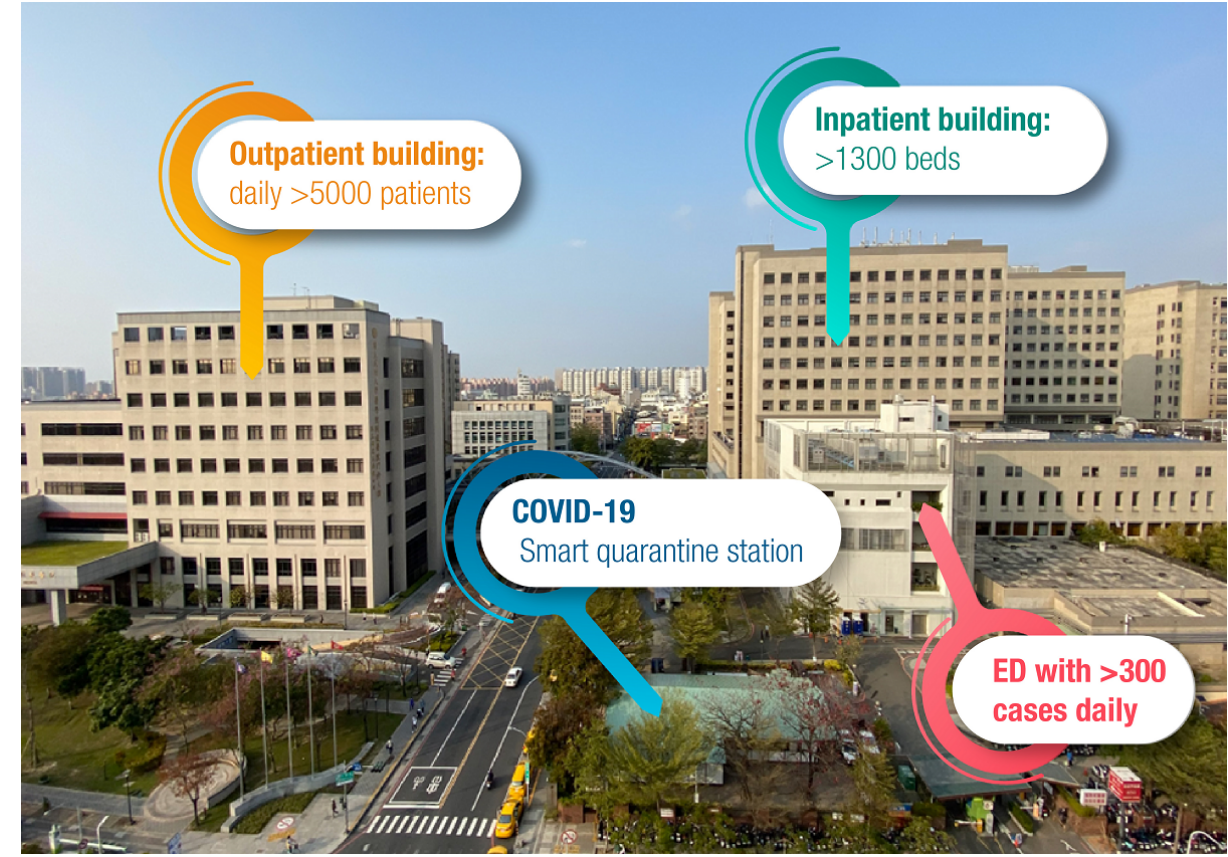
Figure 1. The quarantine station at National Cheng Kung University Hospital. ED: emergency